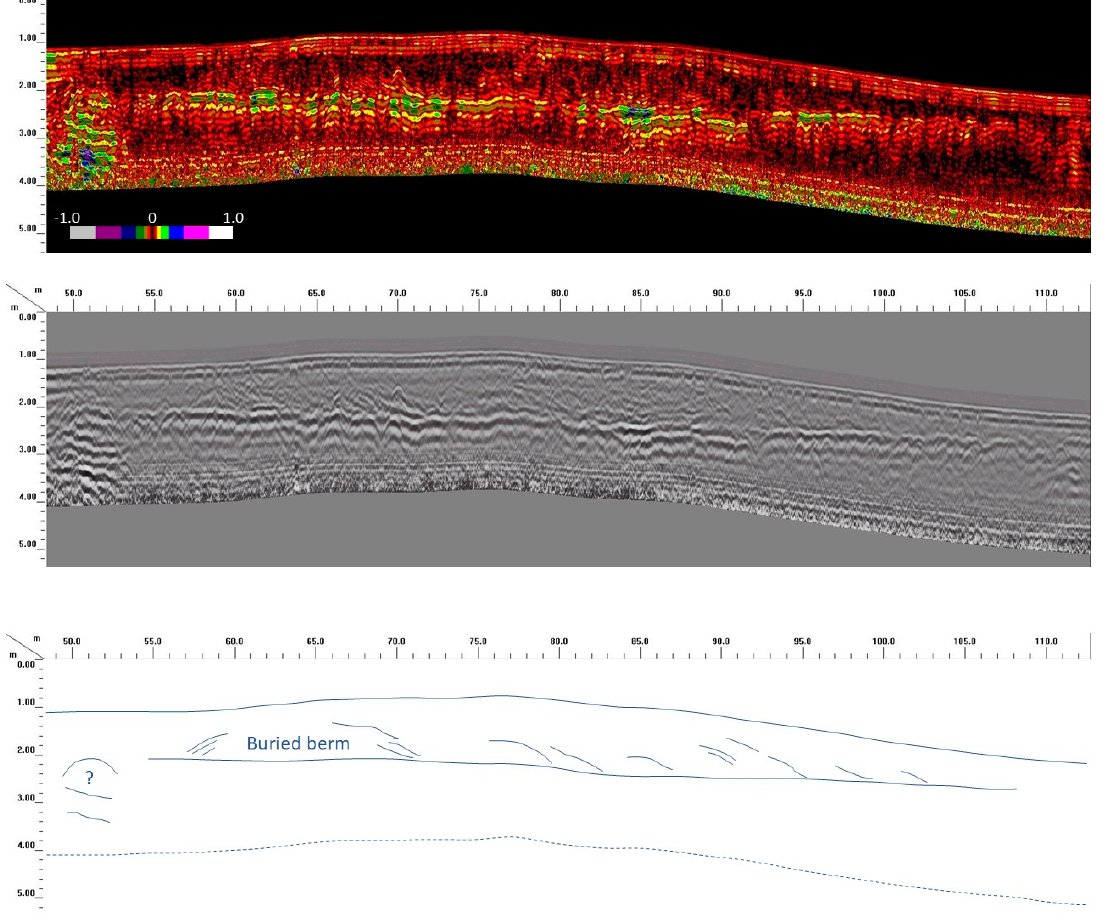
Figure 7. GPR profile and interpretation for the 1725 m shoreline. In the upper transect, data are presented with a color scale to highlight the normalized intensity of radar reflectors. The lower profile presents the same data in grayscale. In both profiles, landward is to the left and lakeward is to the right. Vertical exaggeration 3×.